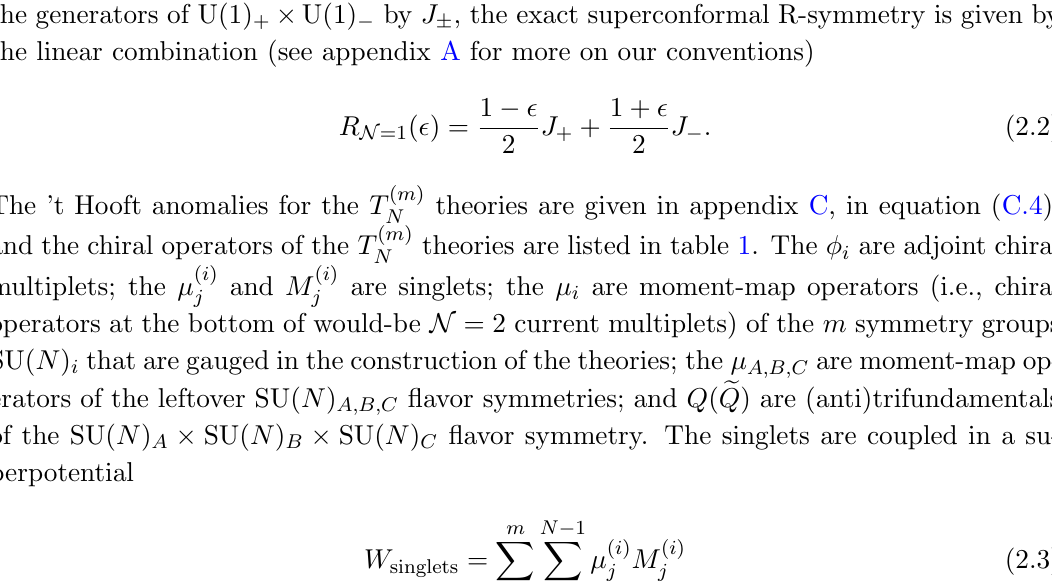
≡ theories. The blue color of N